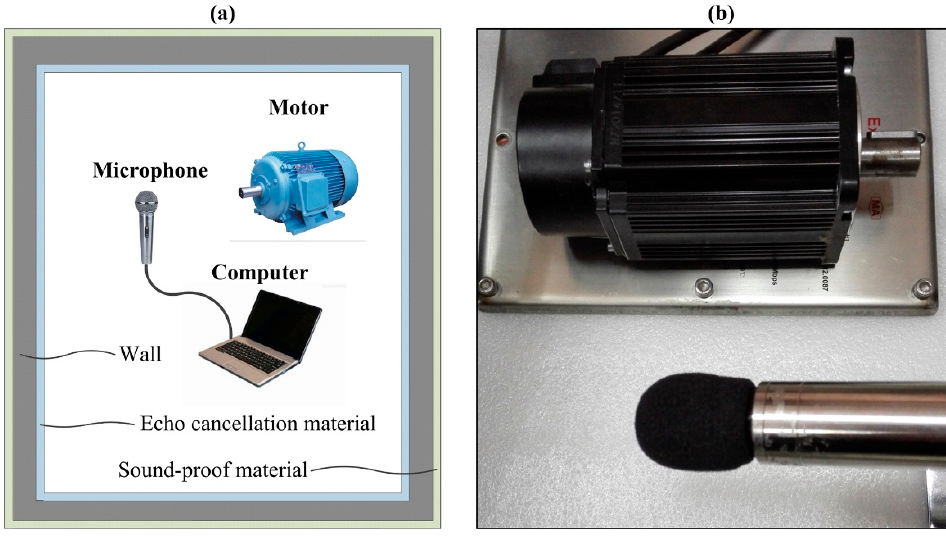
Figure 5. ( a ) Schematic of the soundproof testing branch; and ( b ) The sound recorded in site.